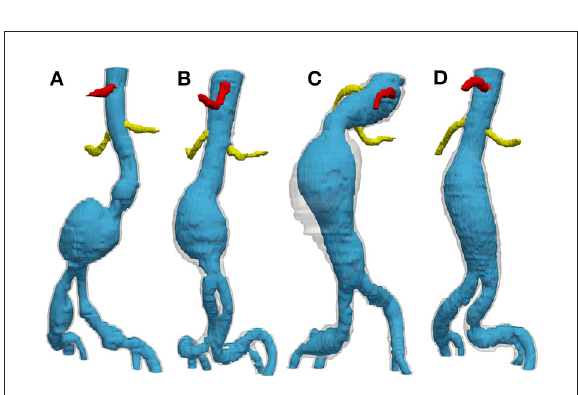
FIGURE5 3D reconstruction obtained from the results of the automatic segmentation model for four different patients (A–D) . For each patient, the lumen is visualized in blue, the aortic ILT/wall is transparent, while the celiac and renal arteries are shown in red and yellow,